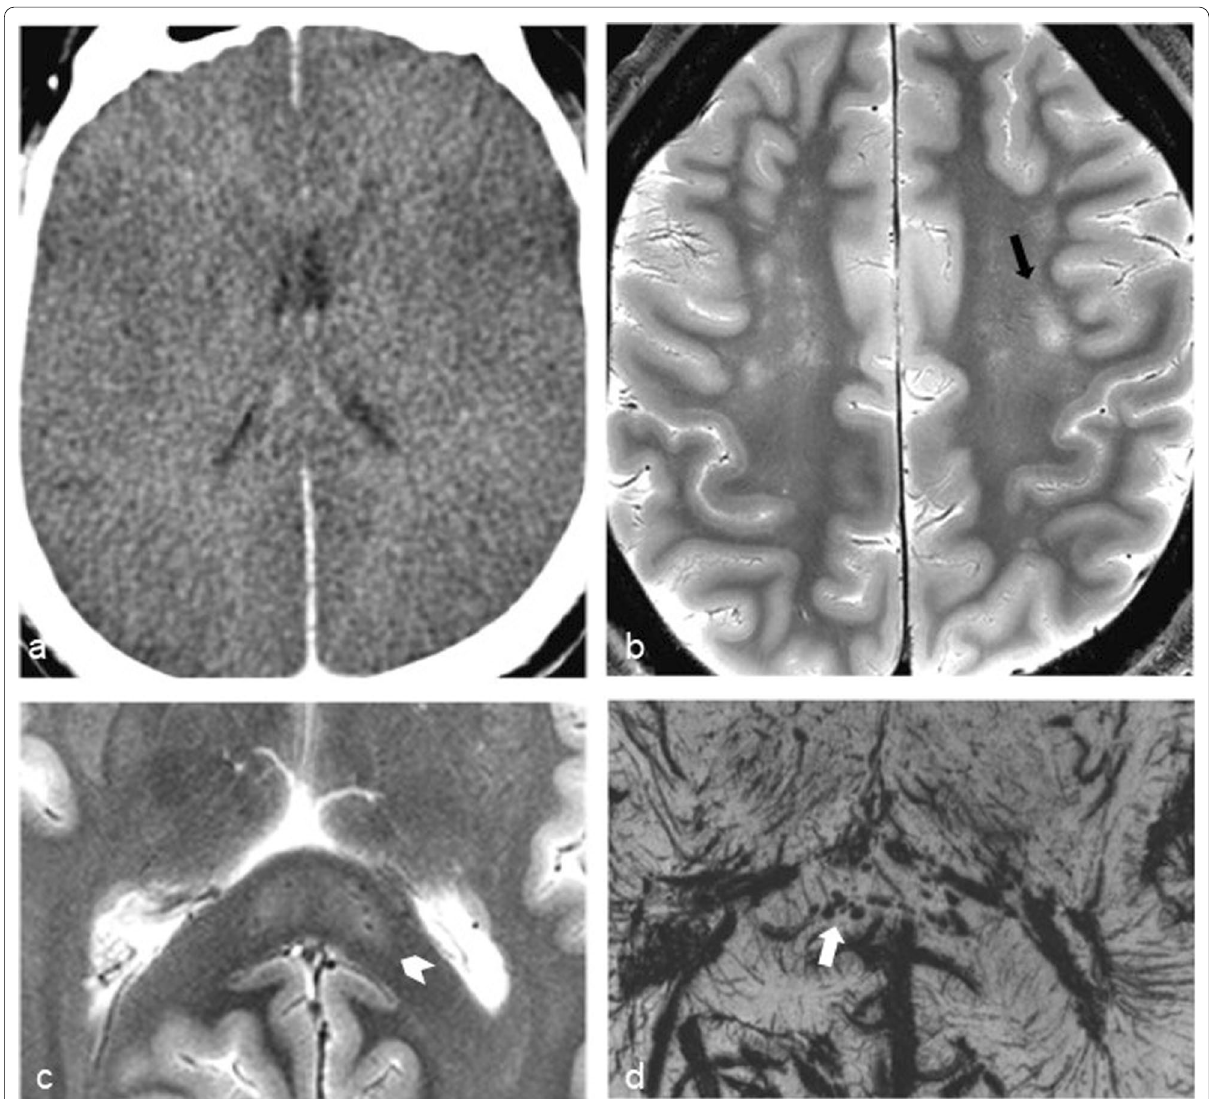
Fig. 4 Diffuse edema (CT a ) and some patchy white matter focal abnormalities (axial T2 b ) (black arrow) in patient 3. Patient 4 had splenial signal abnormality (white arrowhead) with high T2 signal ( c ) with punctate hemorrhagic foci on SWI ( d ) (white